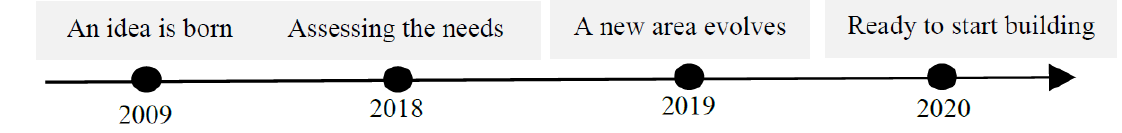
Figure 2. The Rosengård Transit-Oriented Development timeline. Source: the author, 2019.